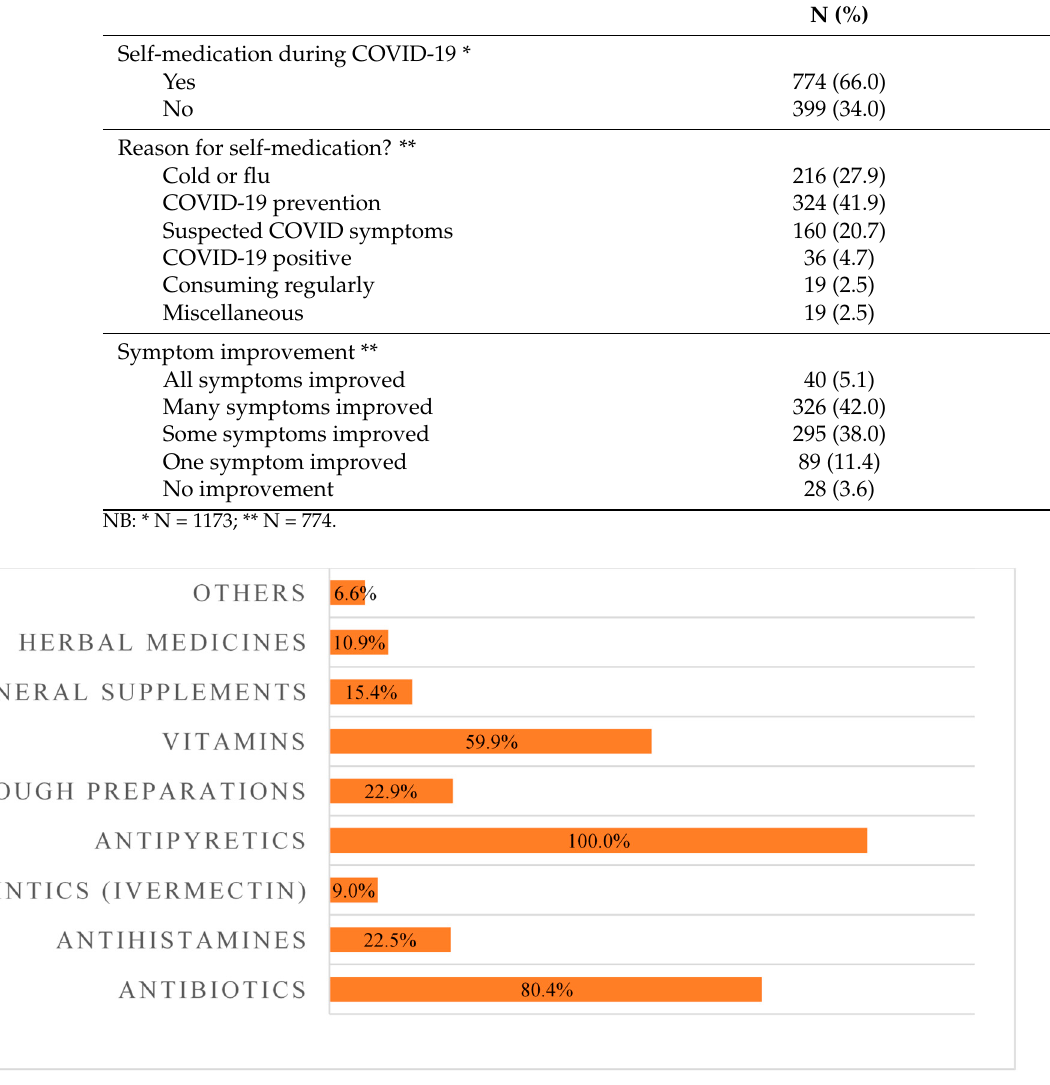
Table 4. Respondents’ practices related to self-medication amid the COVID pandemic.